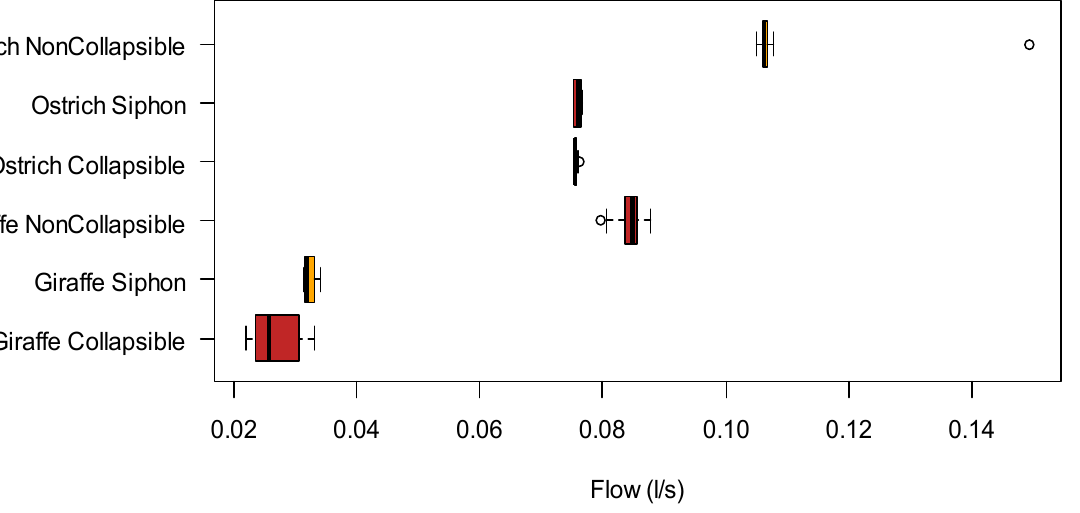
Table 3. ANOVA summary of species, measures and species: measures.